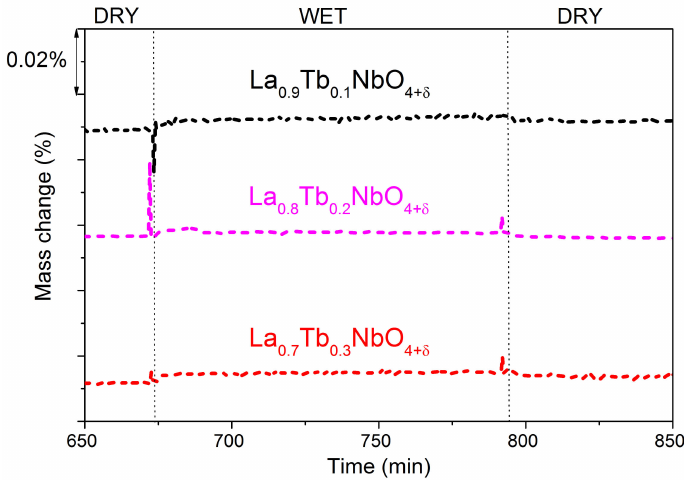
Figure 5. Results of TGA measurements performed for La 0.9 Tb 0.1 NbO 4+ δ , La 0.8 Tb 0.2 NbO 4+ δ , La 0.7 Tb 0.3 NbO 4+ δ